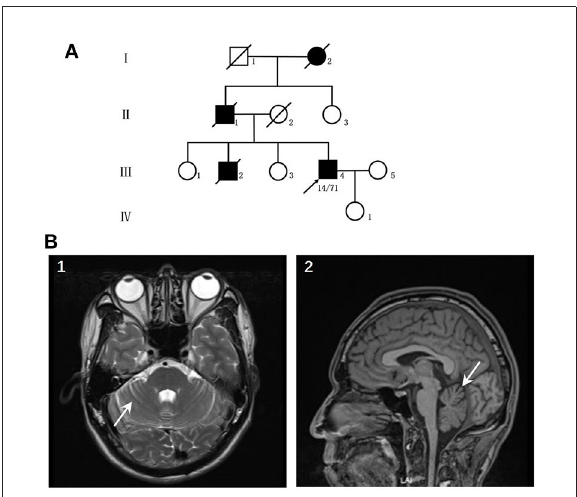
FIGURE1 (A) Pedigree of the patient’s family. (B) Neuroimaging features of the patients. (1–2) patient’s MRI revealed prominent cerebellar atrophy